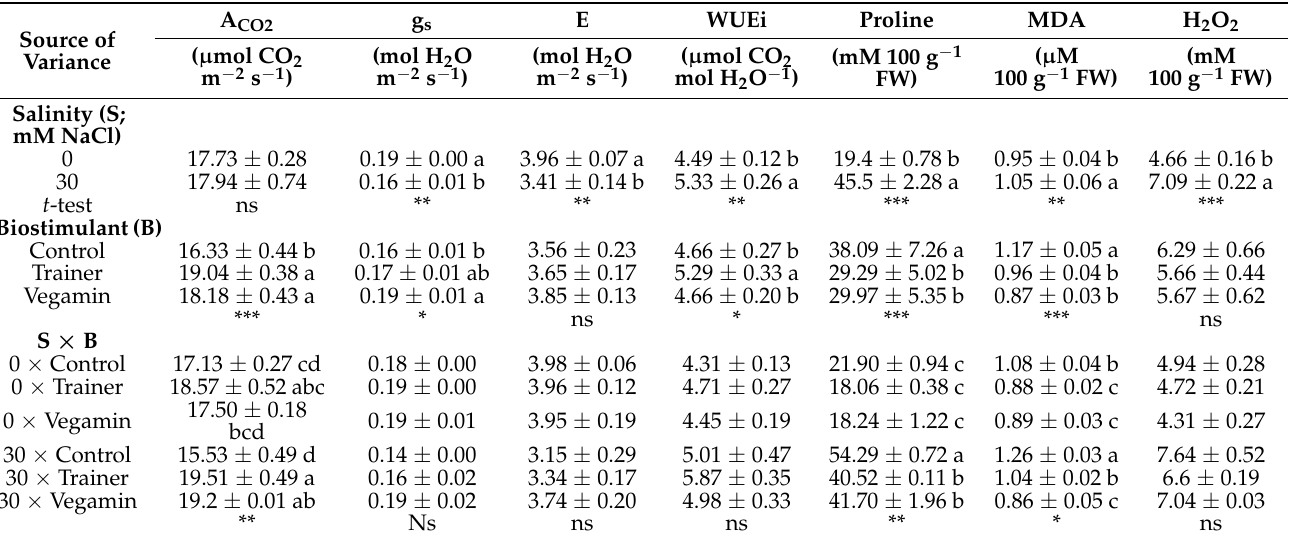
Table 2. Photosynthetic and biochemical parameters of lettuce plants as affected by salinity and biostimulant